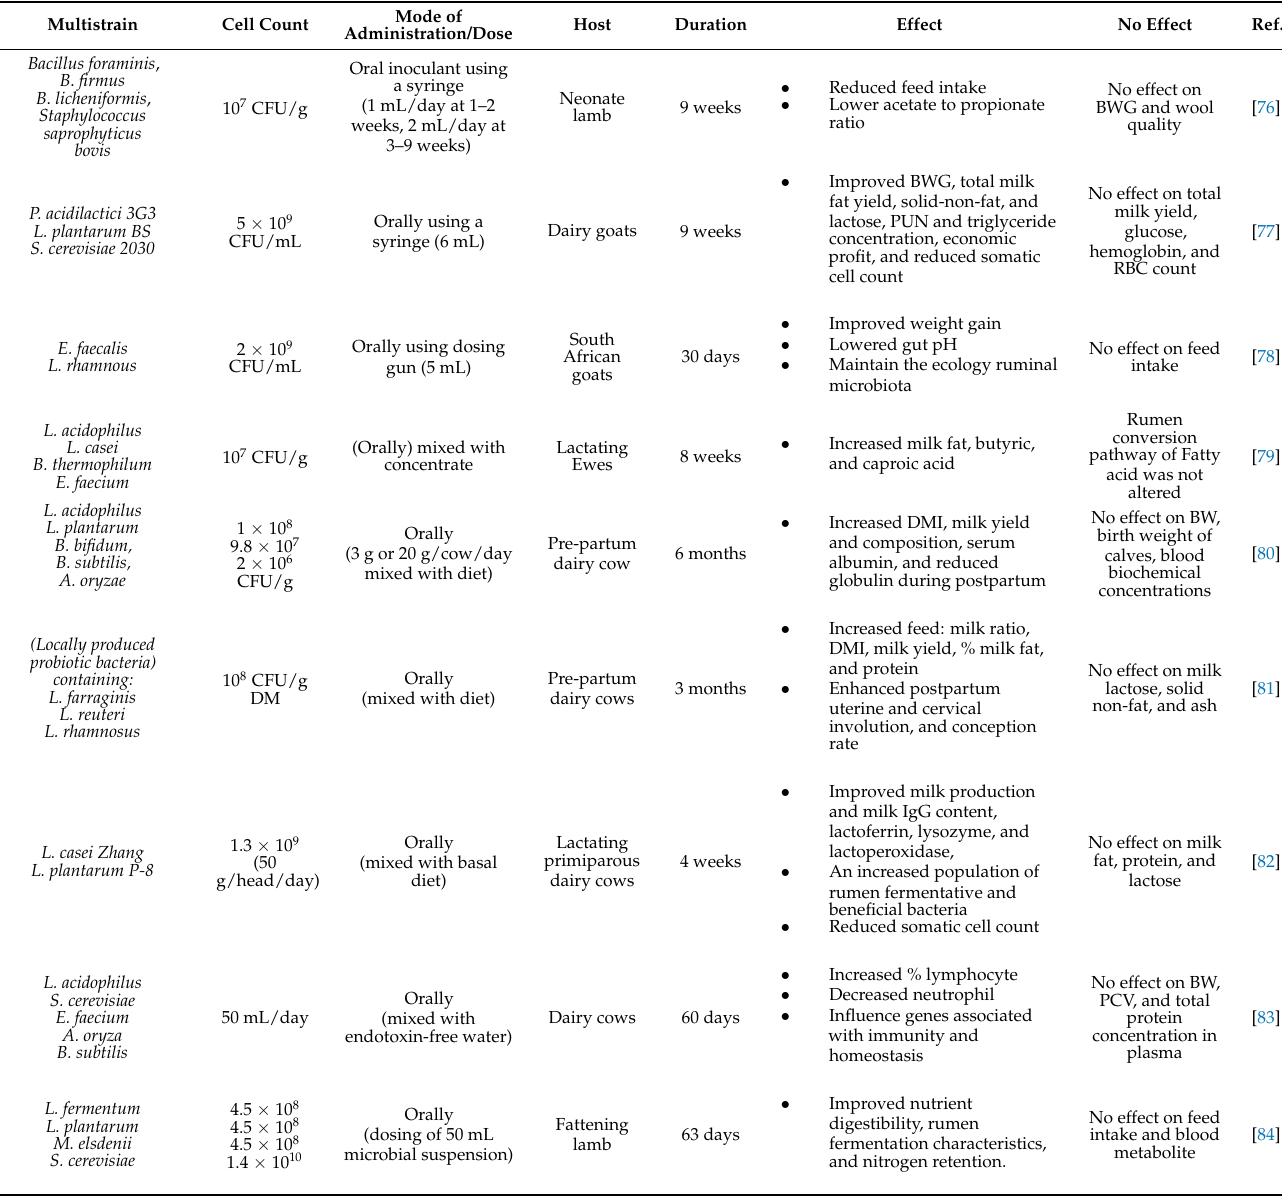
Table 1. Various combinations of multistrain probiotics and their effect on ruminant